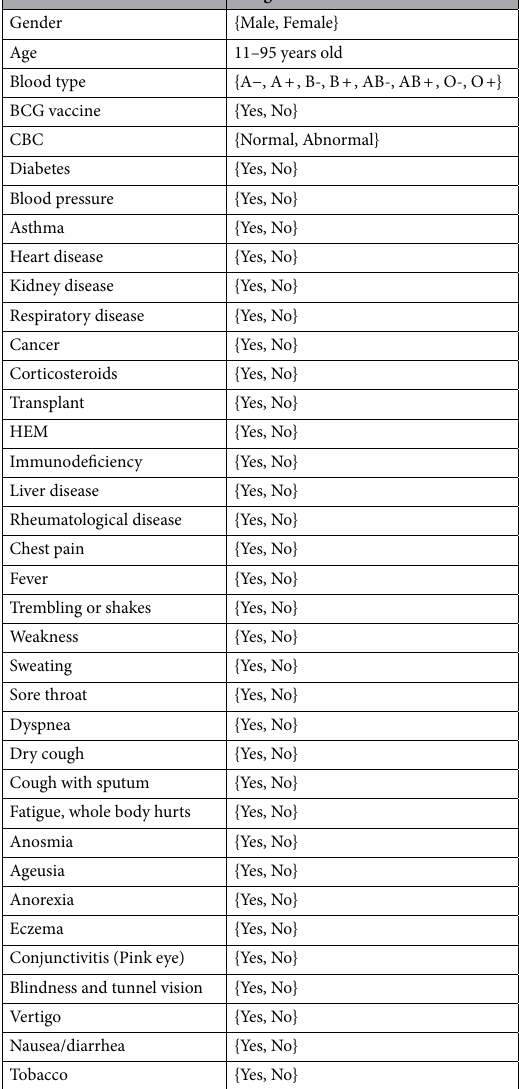
Table 2. Description of the dataset features used for